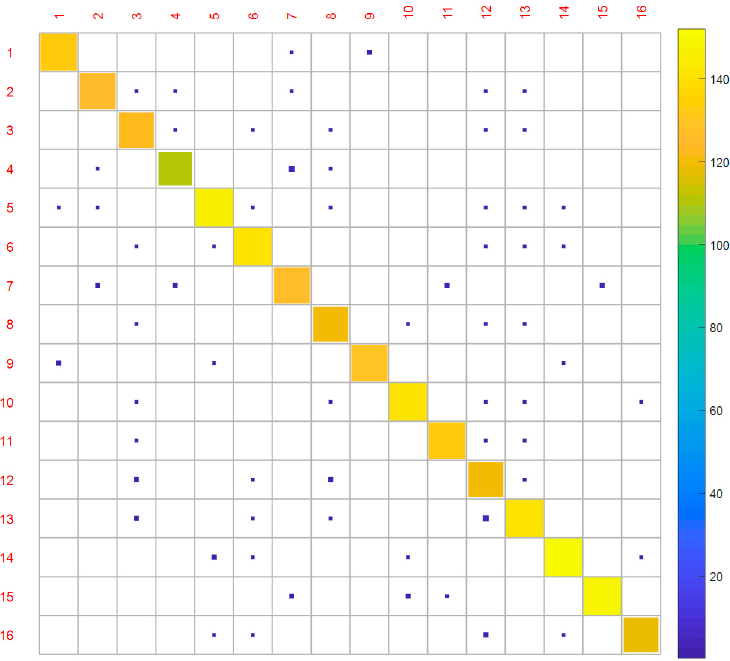
Figure 10. VGG classification results displayed in the confusion matrix. Figure 9. VGG classification results displayed in the confusion matrix.